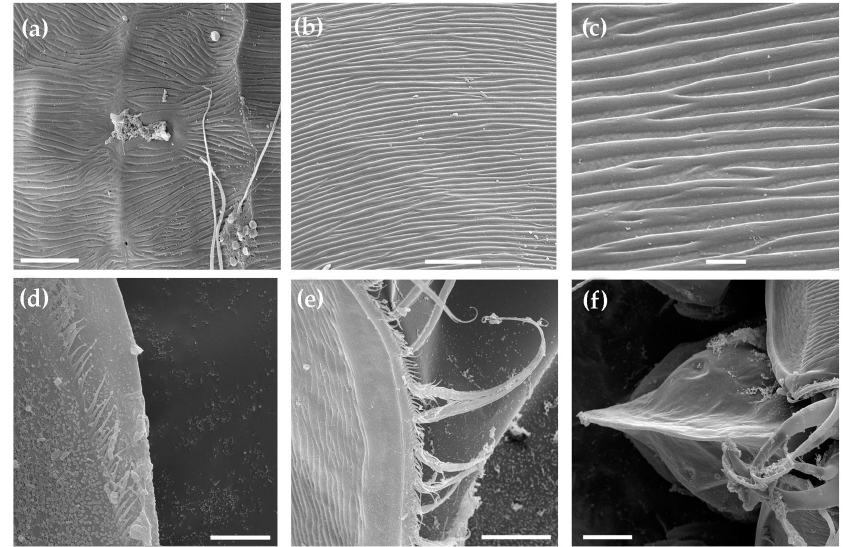
Figure 13. Anthalona mediterranea , an adult parthenogenetic female from Wadi Maidaq — Blue Pool, United Arab Emirates. ( a ) Lateral and main head pores; ( b , c ) ornamentation of valves, outer view; ( d ) ornamentation of valve, posterior portion, inner view; ( e ) ornamentation of valve, ventral portion, inner view; ( f ) labral keel, ventral view. Scale bars: 0.01 mm for ( a , b , e , f ), 0.005 mm for ( d ), 0.002 mm for ( c ).